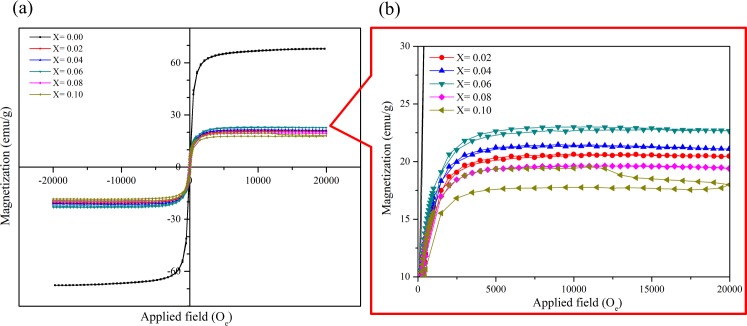
Magnetic properties of La3+ substituted Ni-Zn ferrite nanoparticle hysteresis loops.Hysteresis loops of (a) Ni0.5Zn0.5LaxFe1-xO4 nanocrystals at various La3+ substitution concentrations (b) Enlarged view of hysteresis loop.